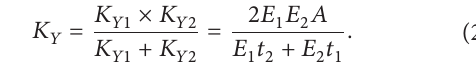
𝑡 󸀠 2 represent the thickness of the compression zone in the segment lining and secondary lining, respectively, m; 𝐴 is the corresponding area of single radial compression bar element in the junction surface: 𝐴 = 𝐵 × 𝜃 × 𝑅 𝐻 , m 2 ; 𝐵 is the width of the single segment lining in the longitudinal direction, m; 𝜃 is the corresponding calculating angle of the single compression bar element in the junction surface; 𝑅 𝐻 is the radius of the junction surface,